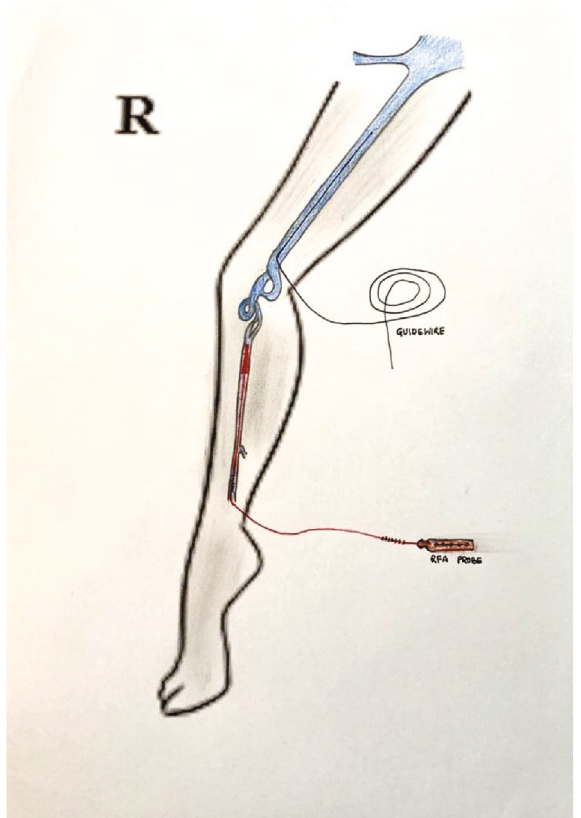
Figure 9: Tortuous GSV needing a double-prepuncture